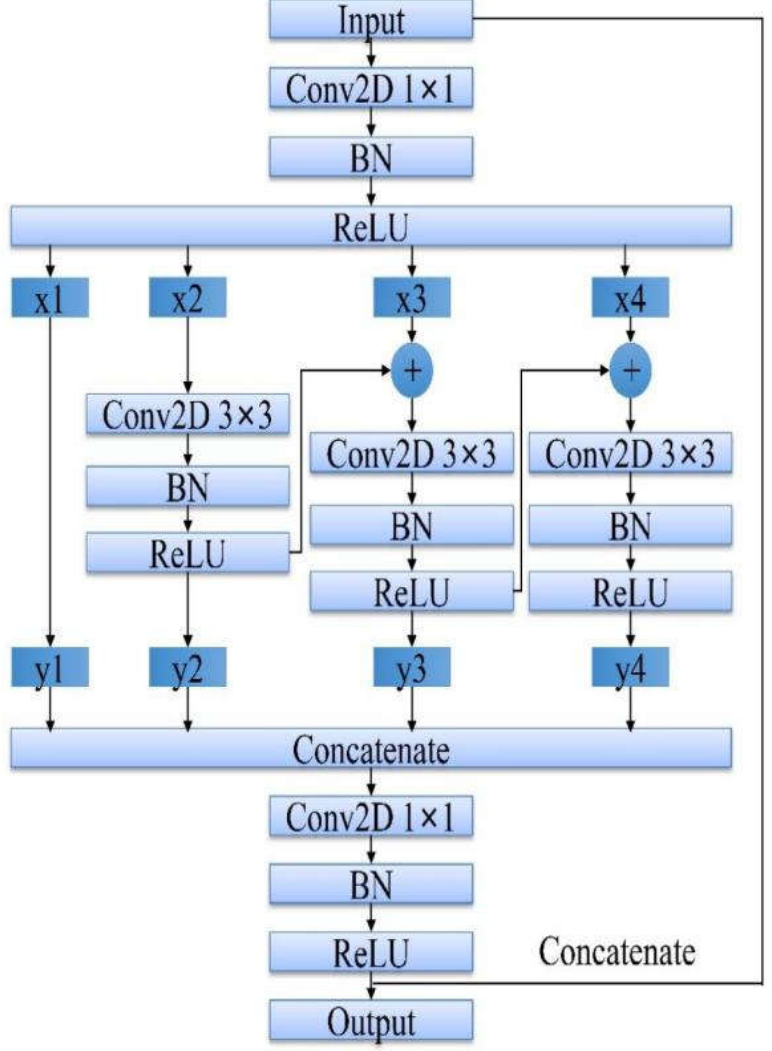
Figure 5. Structure of Res2Net module.